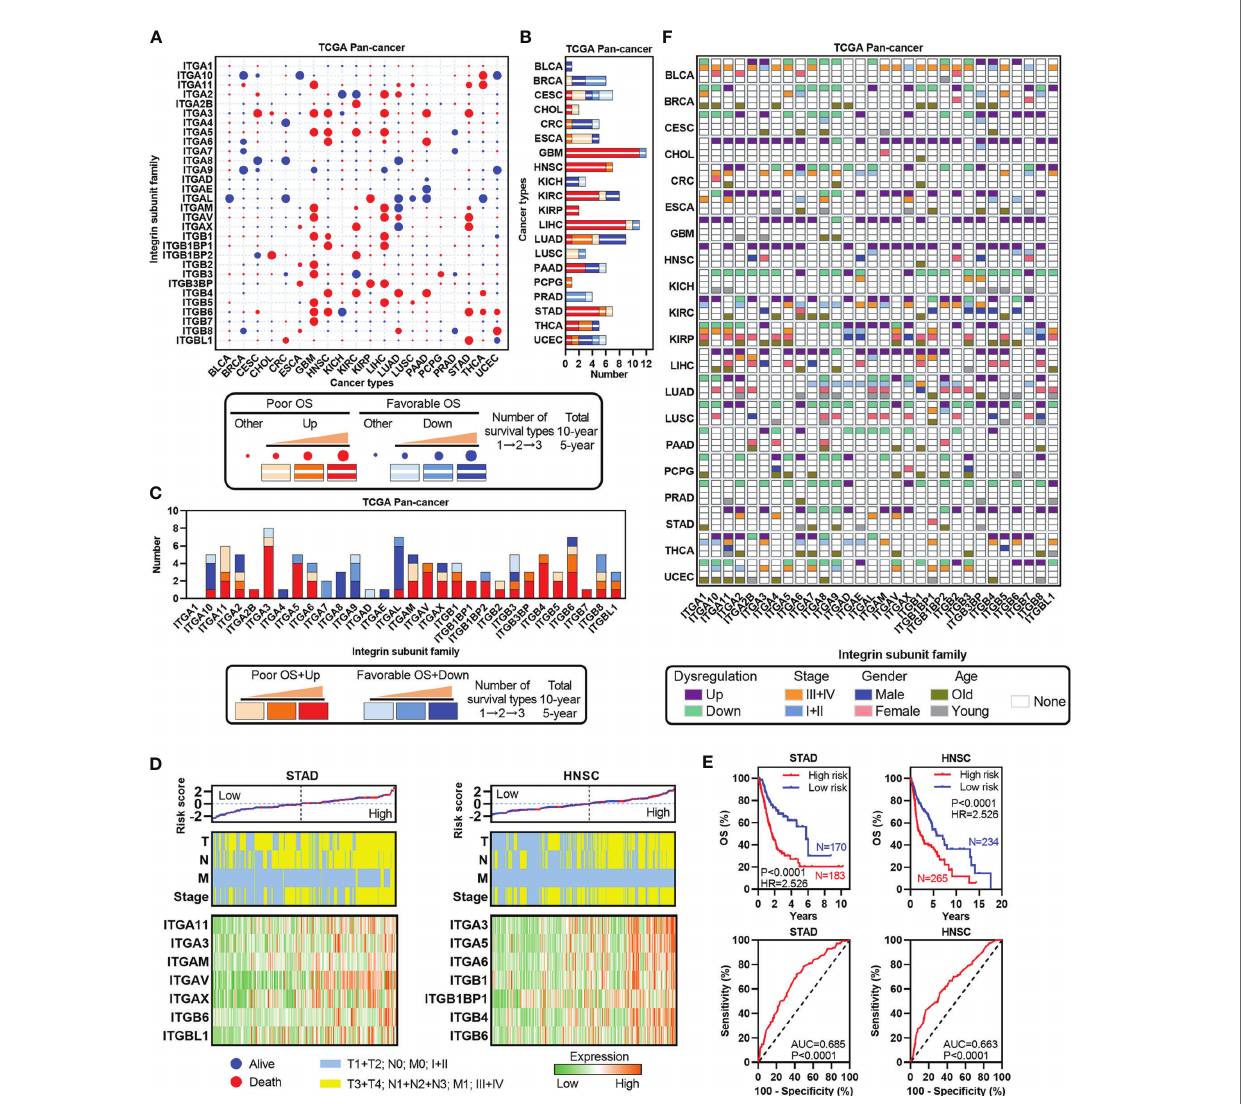
FIGURE 4 | Identi fi cation of dysregulated ITGs with clinical relevance. (A) Heatmap showing the survival types of ITGs across multiple cancers from the TCGA. (B) Barplot showing the number of dysregulated ITGs with clinical relevance for each cancer from the TCGA. (C) Barplot showing the distribution of dysregulated ITGs with clinical relevance across multiple cancers from the TCGA. (D) Risk score distribution with patient OS (top, the black dotted line split the cohort into the high-risk and the low-risk score group), TNM staging indexes (middle) and expression of dysregulated ITGs with clinical relevance (bottom) in STAD and HNSC. (E) Kaplan-Meier plots showing the OS and ROC plots showing the AUC of the risk score in STAD and HNSC. (F) Heatmap showing the correlation among TNM stage, gender, age and expression of ITGs in each cancer